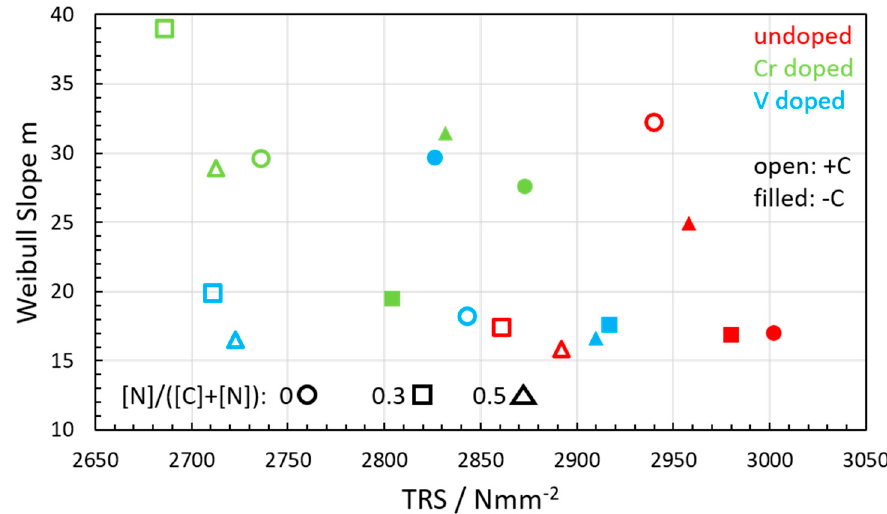
Figure 10. Weibull evaluation for the full set of hardmetals. Symbols correlate with Figure 8. TRS: transverse rupture strength.